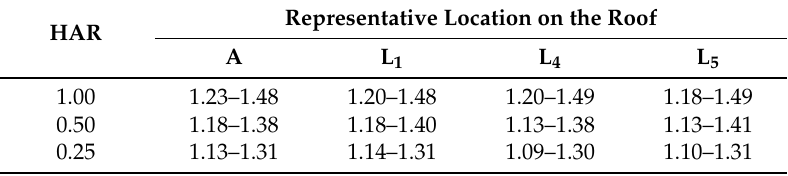
Table A2. Height ranges of relatively favorable wind conditions ( U / U 0 ≥ 0.97 and I U / I 0 ≤ 1) at the representative locations on the roof in the case of no prevailing wind direction. The height ranges are normalized by the height of the buildings, H